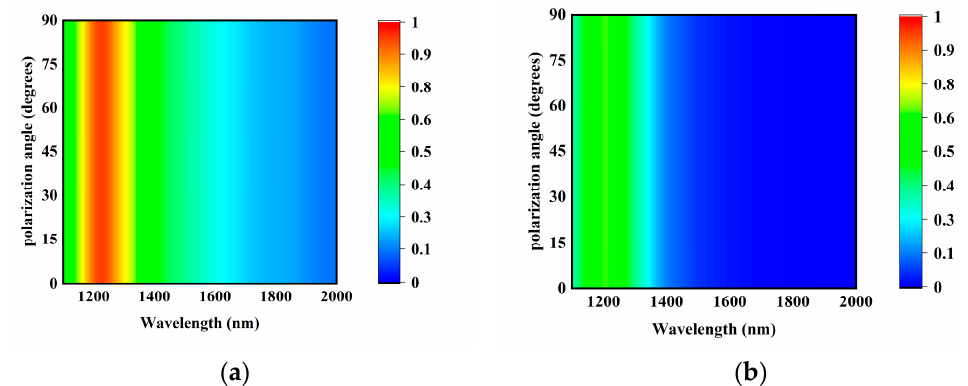
Figure 6. The polarization angle dependence for ( a ) the structure of Au/Si NP arrays/Au and ( b ) the structure of Au/Si NP arrays.